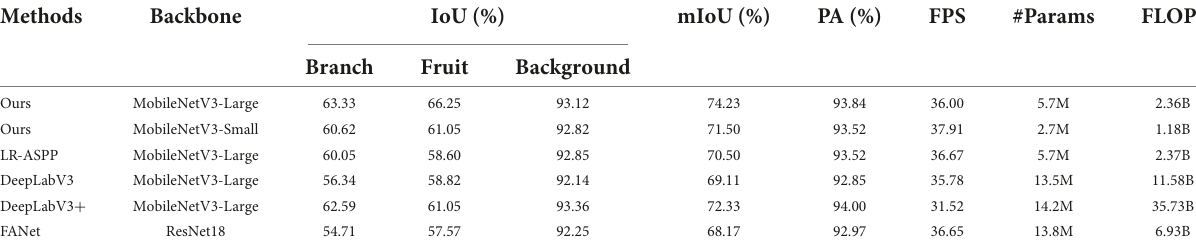
TABLE 3 Accuracy and real-time performance of the proposed network and comparison methods on test set.